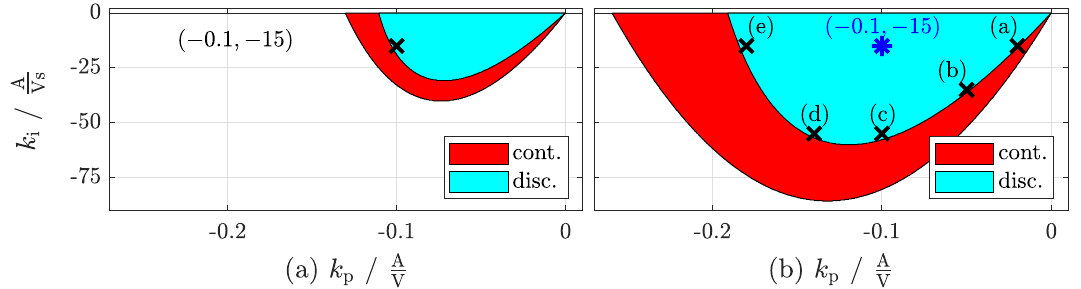
Figure 7. ( a ) Worst case scenario used for the choice of PI controller parameters. The combination of k p and k i has to be within the discrete-time region (cyan area) due to the low sampling frequency. ( b ) Stability region for operating point i d (cid:63)